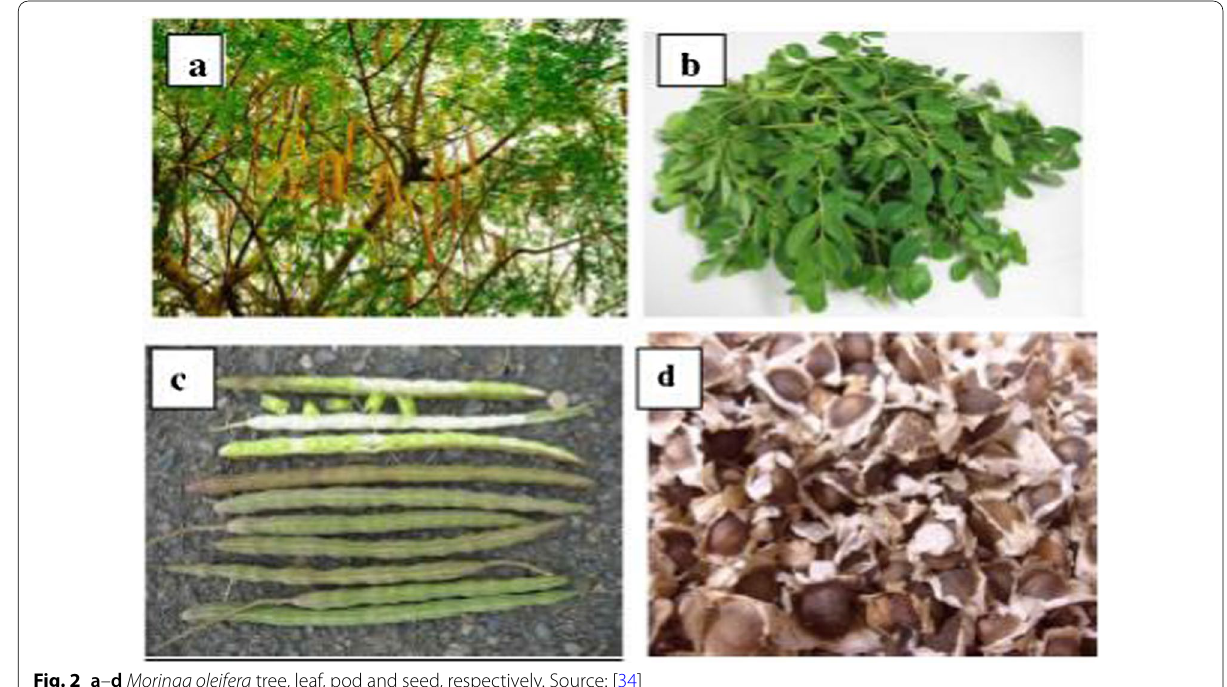
Fig. 2 a – d Moringa oleifera tree, leaf, pod and seed, respectively. Source: [34]